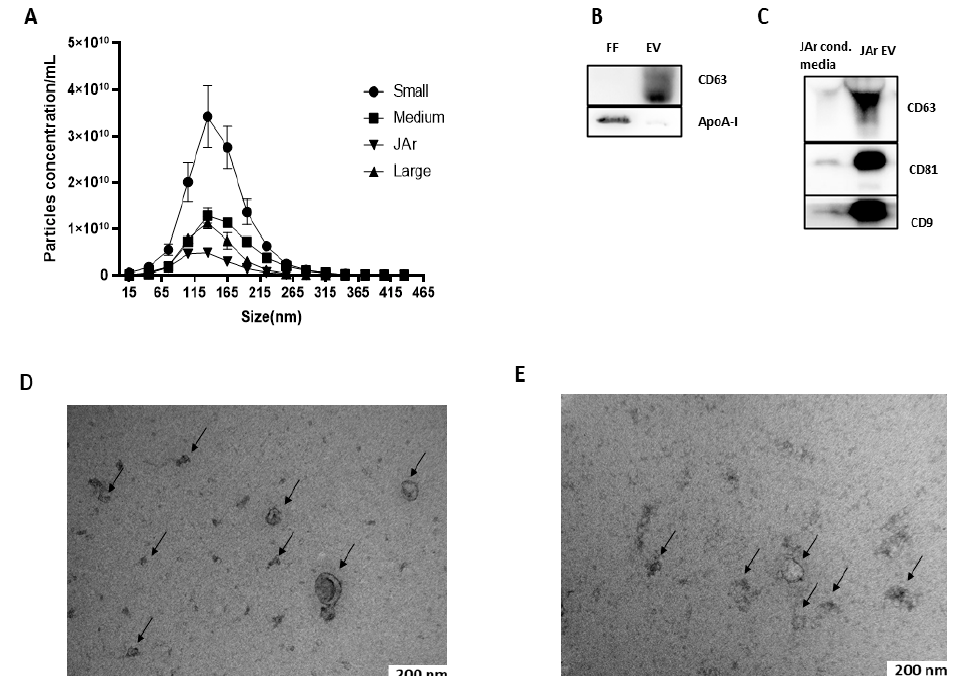
Figure 1. Characterization of FF EVs and JAr EVs. ( A ) Size profile and concentration of EVs measured by NTA. N = 3 of each of the sized follicles. Error bars display mean ± standard deviation (SD). ( B ) Western blot analysis of FF EVs for EV-specific marker. The presence of specific EV marker CD63 in EVs samples confirmed the successful isolation of EVs from FF. The apoA-I marker was used as a purity control for EVs and a strong signal of apoA-I was observed in unpurified FF samples compared to EVs, which indicates that EVs purified from FF by SEC had little or no contamination where ApoA-I indicates the purity of EVs. ( C ) EVs purified from JAr-conditioned medium showed a strong positive signal for EV-specific markers CD63, CD81 and CD9 compared to unpurified JAr-conditioned medium, which showed the enrichment of EVs compared to unpurified samples. ( D ) EVs purified from bovine FF were analyzed by TEM, where the black arrow indicates the typical cup-shaped of EVs. ( E ) EVs purified from JAr-conditioned medium were confirm and characterized by TEM, where the black arrow indicates the typical cup-shaped of